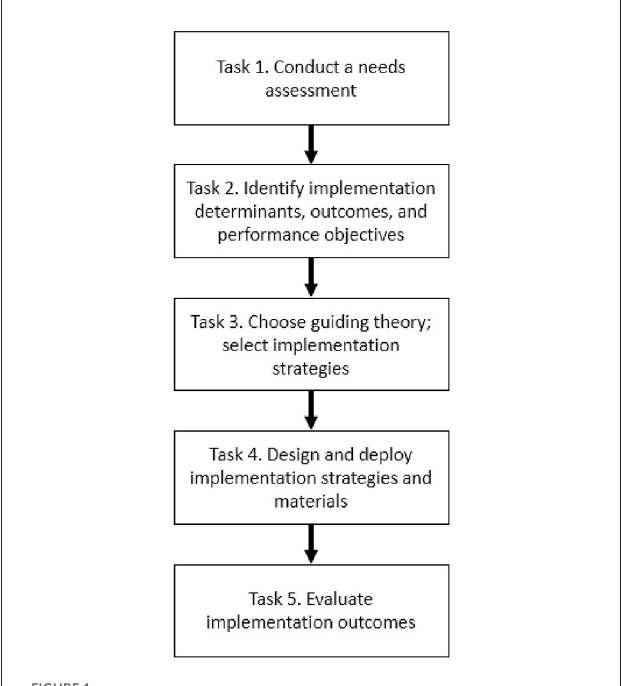
FIGURE1 Implementation mapping steps informed by Fernandez et al.